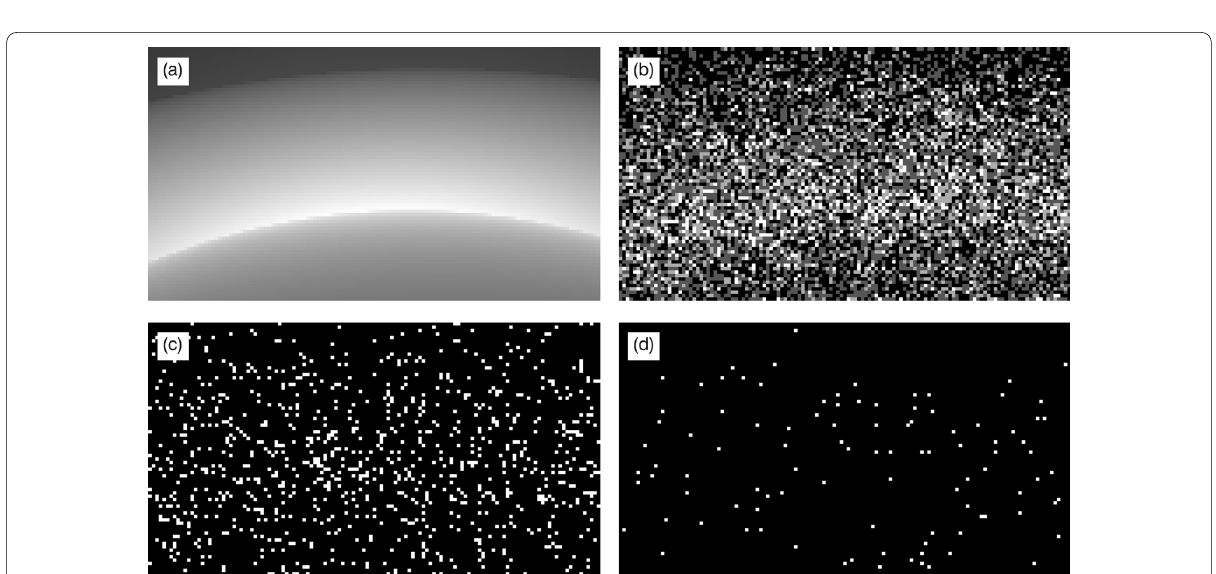
Fig. 6 Fitted soft X-ray images. Fitted images of soft X-ray images in the same format as Fig. 5 (Figure adapted from Jorgensen et al.